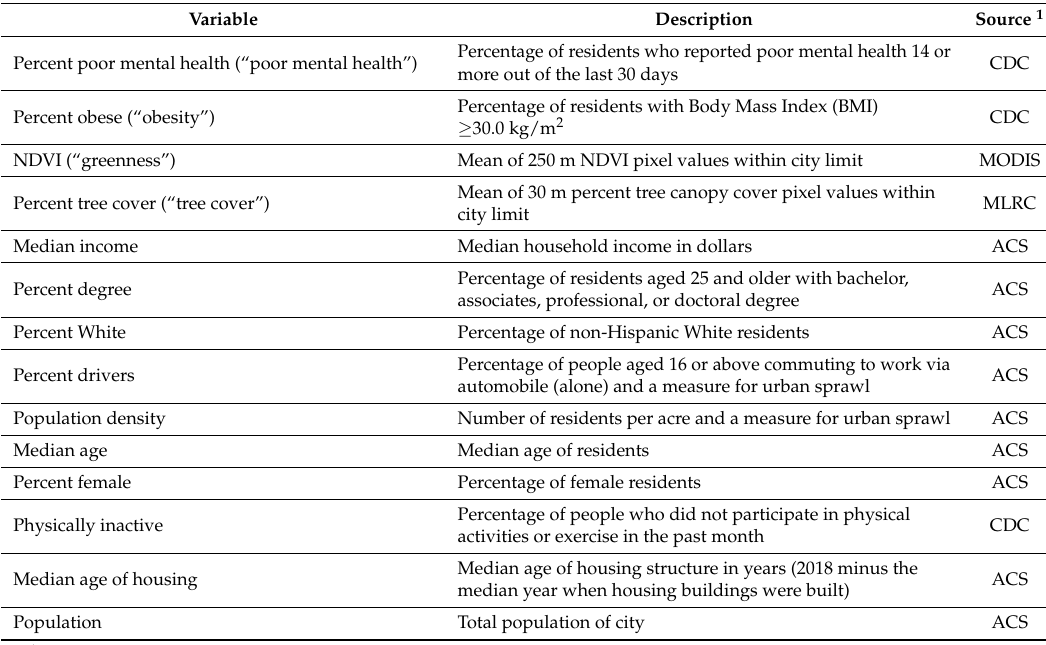
Table 1. Descriptive of variables and data